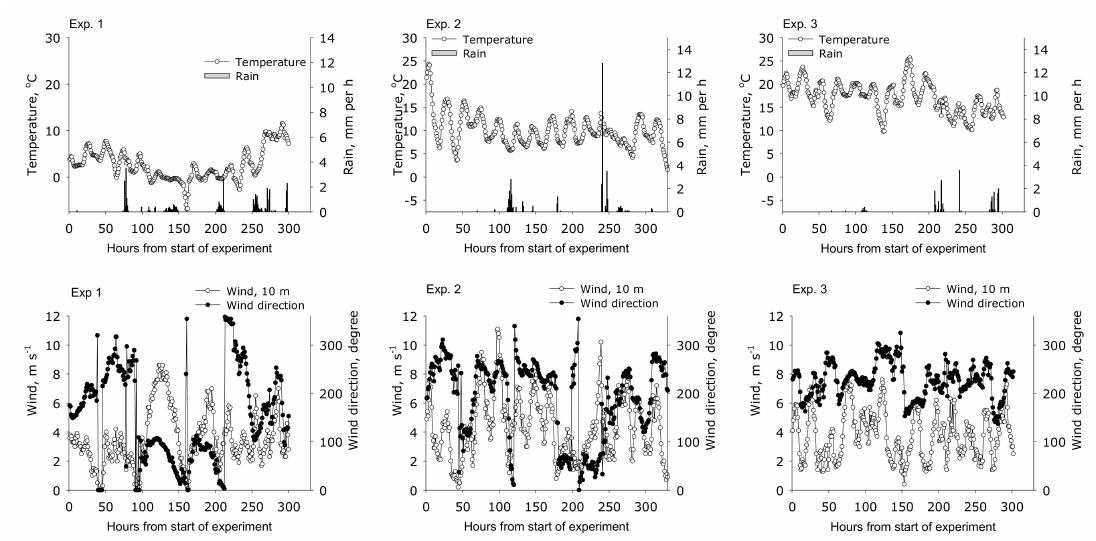
Figure 2. Weather conditions during the experiment in experiment one (March), experiment two (April), and experiment three (August). Top: Temperature and rain. Bottom: wind speed and wind direction at 10 m height (source: Danish Meteorological